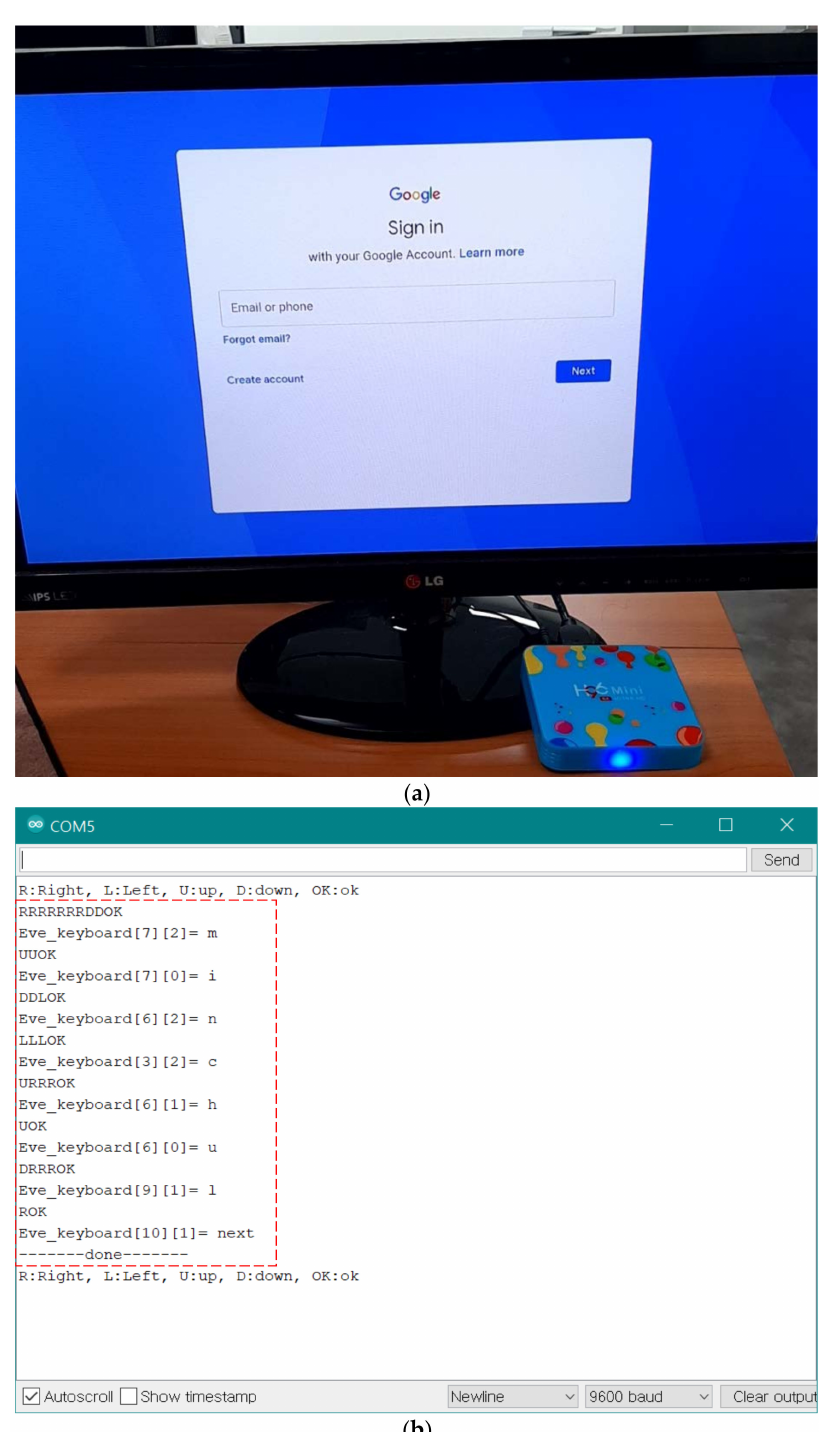
Figure 13. Risk of exposing sensitive information. ( a ) E-mail access with set-top box. ( b ) Picture of eavesdropping ID and